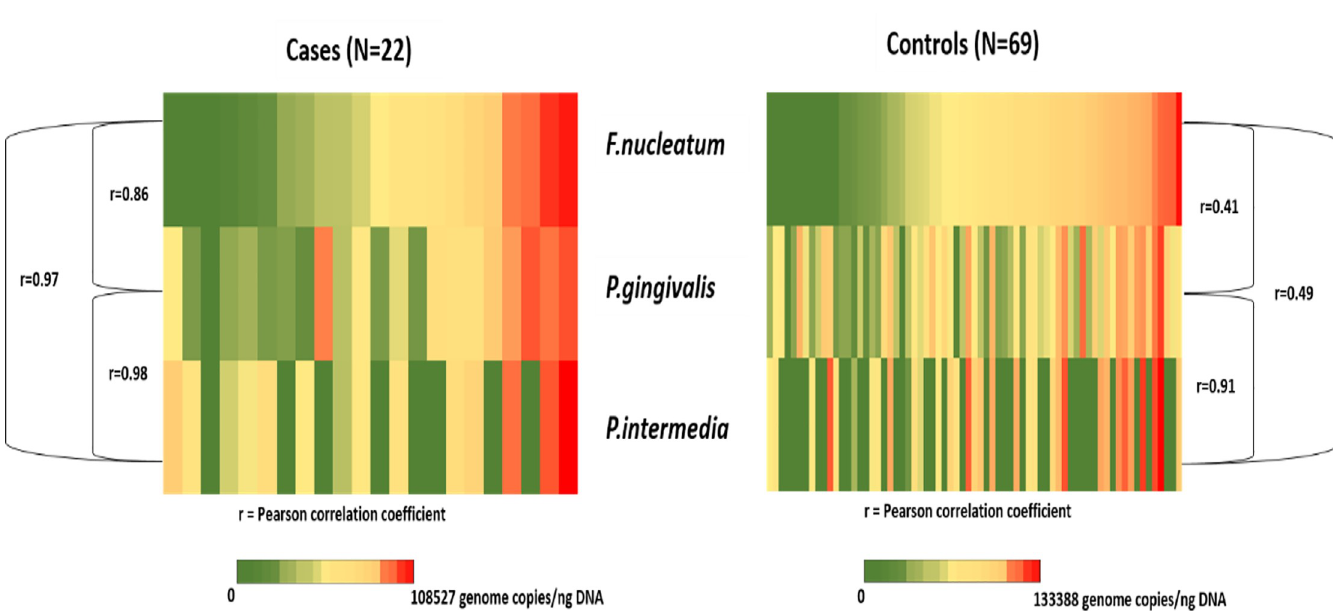
Fig 2. Heat-map showing distribution and correlations of P . gingivalis , F . nucleatum and P . intermedia genome copies in salivary rinse samples of the study participants (N =